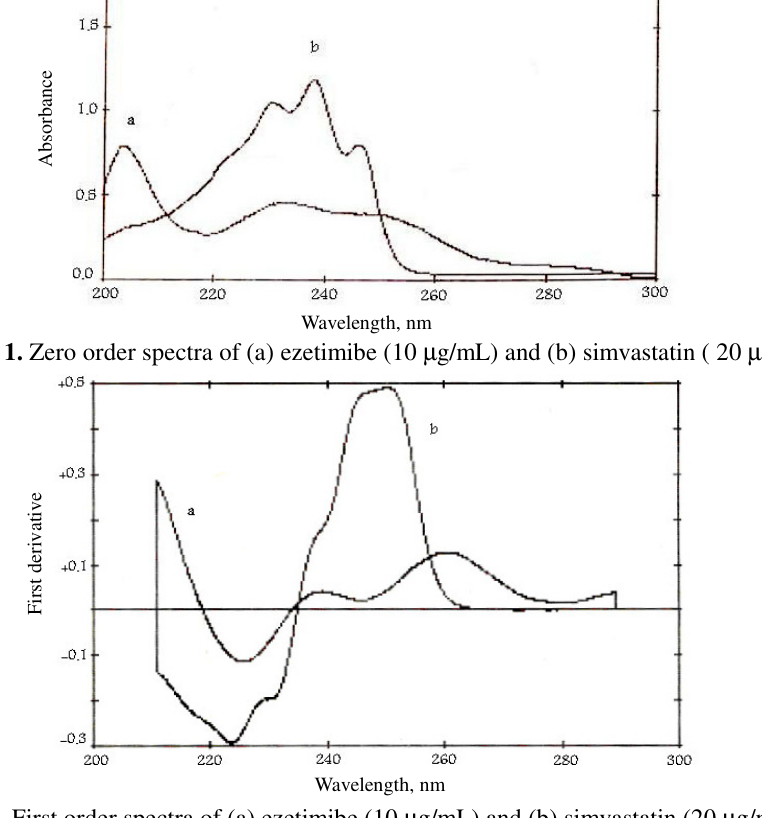
Figure 2. First order spectra of (a) ezetimibe (10 µ g/mL) and (b) simvastatin (20 µ g/mL) Linearity